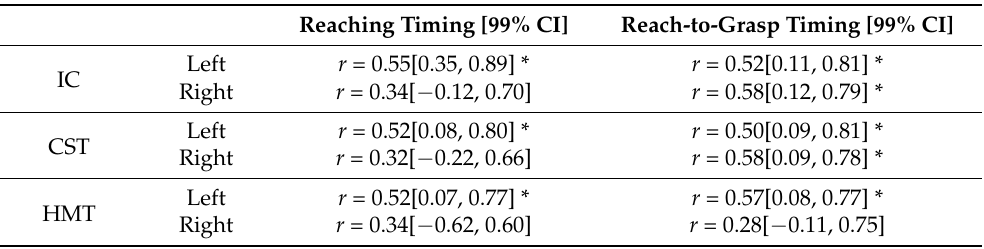
Table 4. Bayesian correlations between HMOA and the Reaching and the Reach-to-Grasp timing com- ponents. HDI: High Density Interval. Credible interval in parentheses; * indicate credible correlations. Reaching Timing [99%